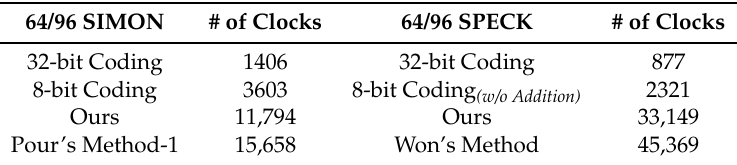
Table 8. Comparison of the total number of operations